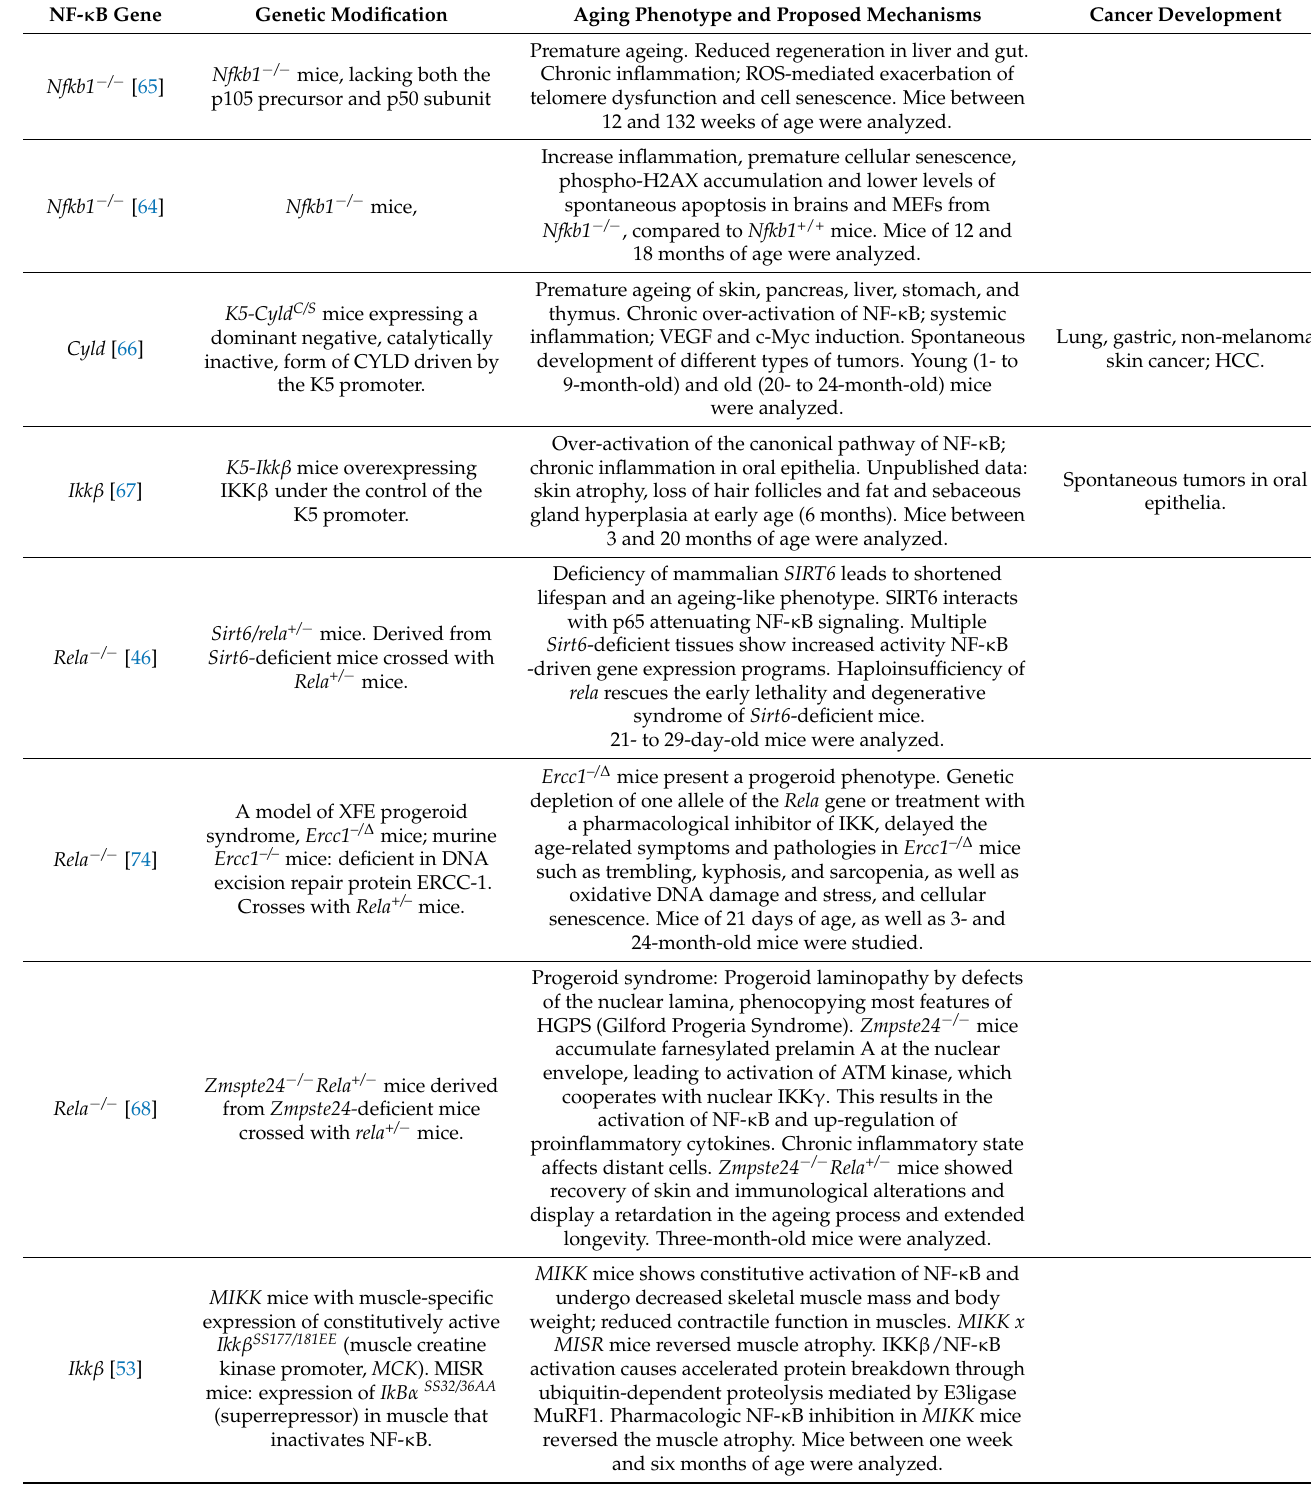
Table 1. Studies related to the activation of NF- κ B and the development of premature aging and aged-related cancer. NF- κ B